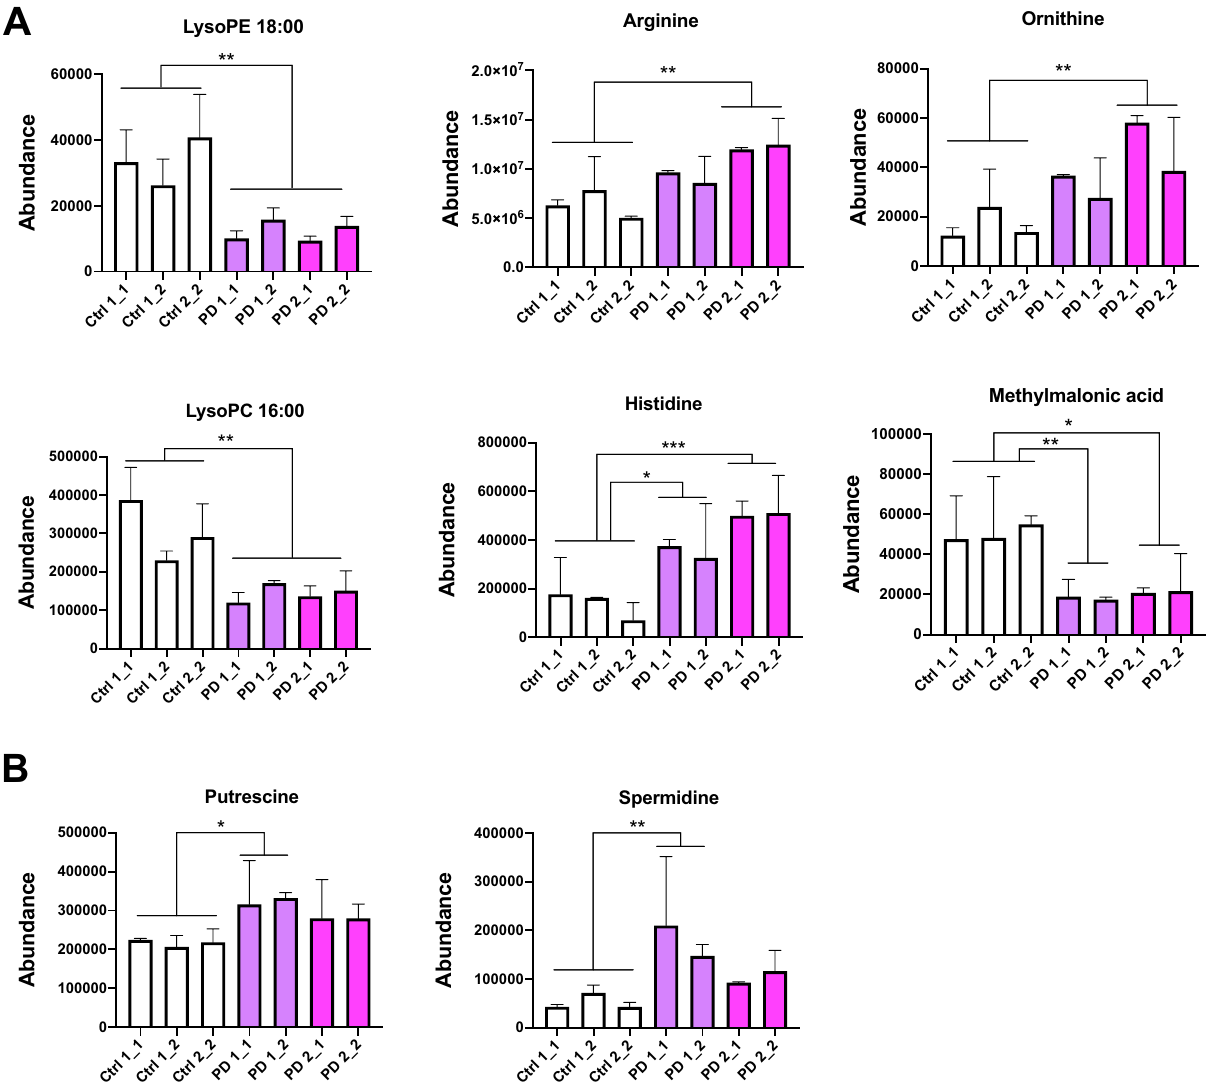
Figure 6. Non-targeted metabolite profiling of astrocytes revelaled several statistically significantly differentiating compounds in cell lysates ( A ) and media ( B ) of healthy and PD astrocytes analyzed by UHPLC- QTOF-MS. Bars represents mean ± SD, *p < 0.05, **p < 0.01, ***p < 0.001. LysoPE lysophosphatidylethanolamine, LysoPC